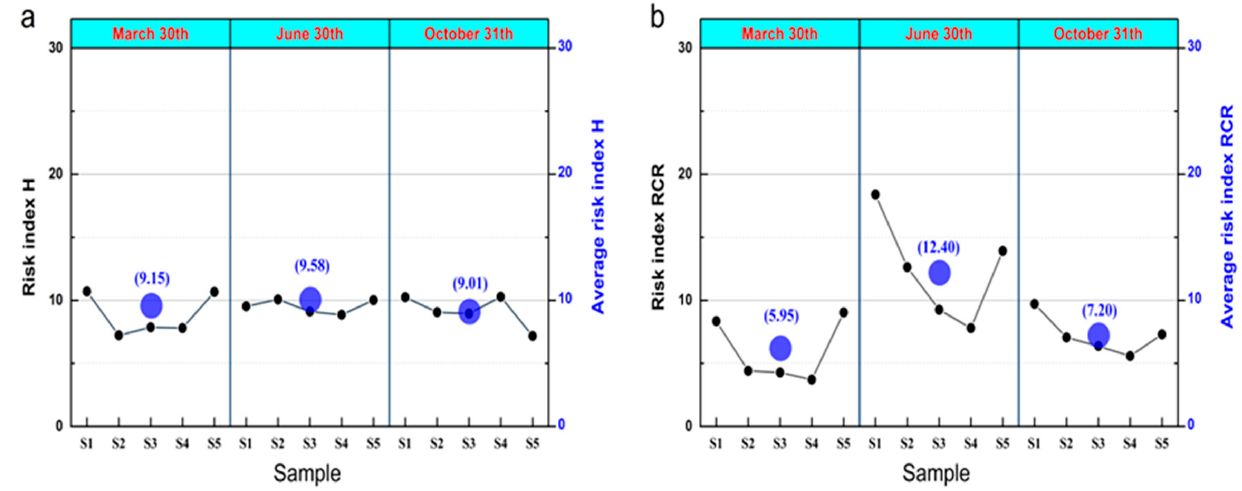
Figure 6. The risk value H and RCR of MPs in groundwater: ( a ) H risk index and ( b ) RCR risk index.